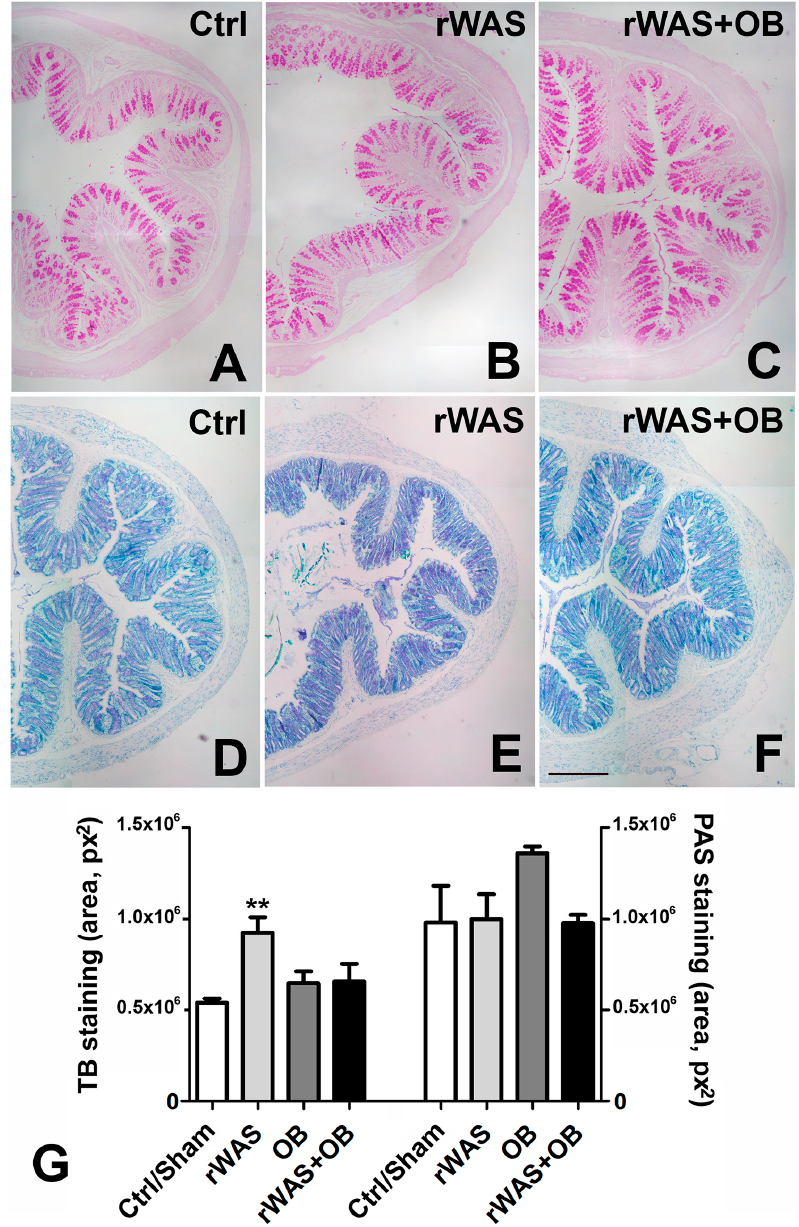
Figure 1. Mucus secretion. Periodic Acid and Schiff’s reagent (PAS) ( A – C ) and Toluidine Blue (TB) staining ( D – F ). The two stainings were located in the glandular funds and in the goblet cells. Quantitation of PAS staining showed no difference in the total quantity of mucus production among the groups of rats (( G ), right columns). Conversely, the quantitation of the acidic component, measured as TB metachromasia, demonstrated a significant increase in the rWAS group compared with the other three (( G ), left columns). (( A – F ) bar = 50 µm). One-way ANOVA followed by Newman–Keuls post-test, ** p < 0.005. (n = 7), Bar = 100 µm.